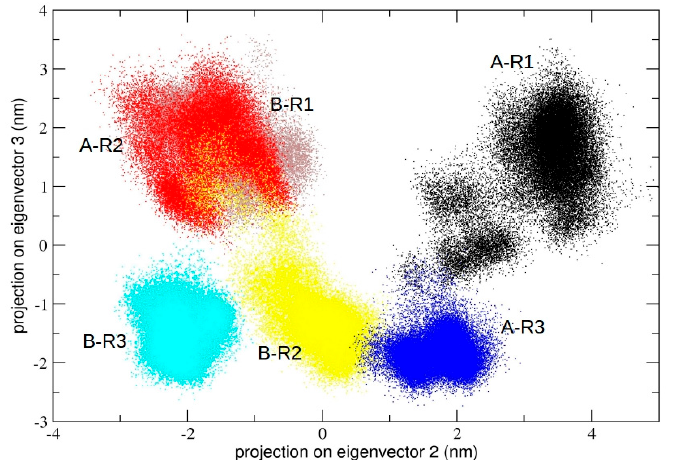
Figure 5. 2D projection of all trajectories onto the principal plane defined by the second and third eigenvector of the concatenated trajectory of all three dimeric 3CLpro runs (run #1, run #2, and run #3). The projections of the chains from the three independent simulations are shown with different colors according to the following scheme: A-RX and B-RX (with X = 1,2,3) for chain A and B for run #1, #2, and #3, respectively.